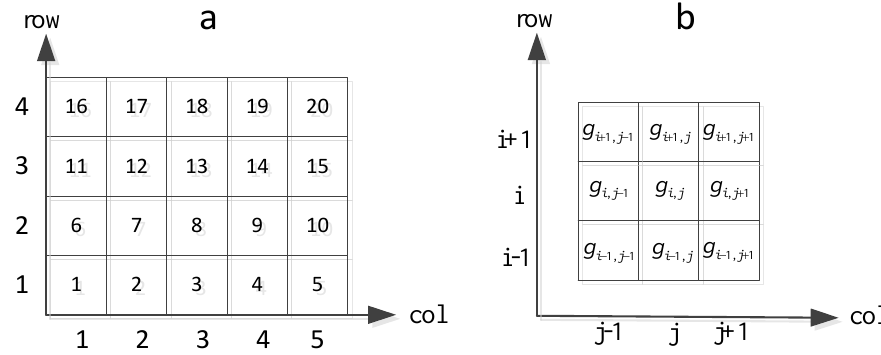
Figure 2. Regional meshing and coding: ( a ) meshing cell coding, ( b ) neighbor cells of g ij .